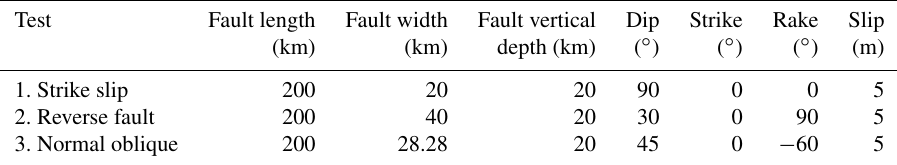
Figure 2. (a) Diagram of the fault plane (shaded grey) in the Abaqus mesh with co-located node pairs and local coordinate system aligned with the fault plane; (b) close-up of a node pair ( m , n ) and dummy node ( d ) with displacement boundary condition applied in the x direction of the local coordinate system (for illustrative purposes only, the fault is not allowed to open in the z direction); (c) constraint equations applied to the node pair results in displacement of nodes m and n in the x direction. Table 1. Fault geometry used in the three benchmarking exercises. Note that test case 3 is run with three Earth models; see Table 2.